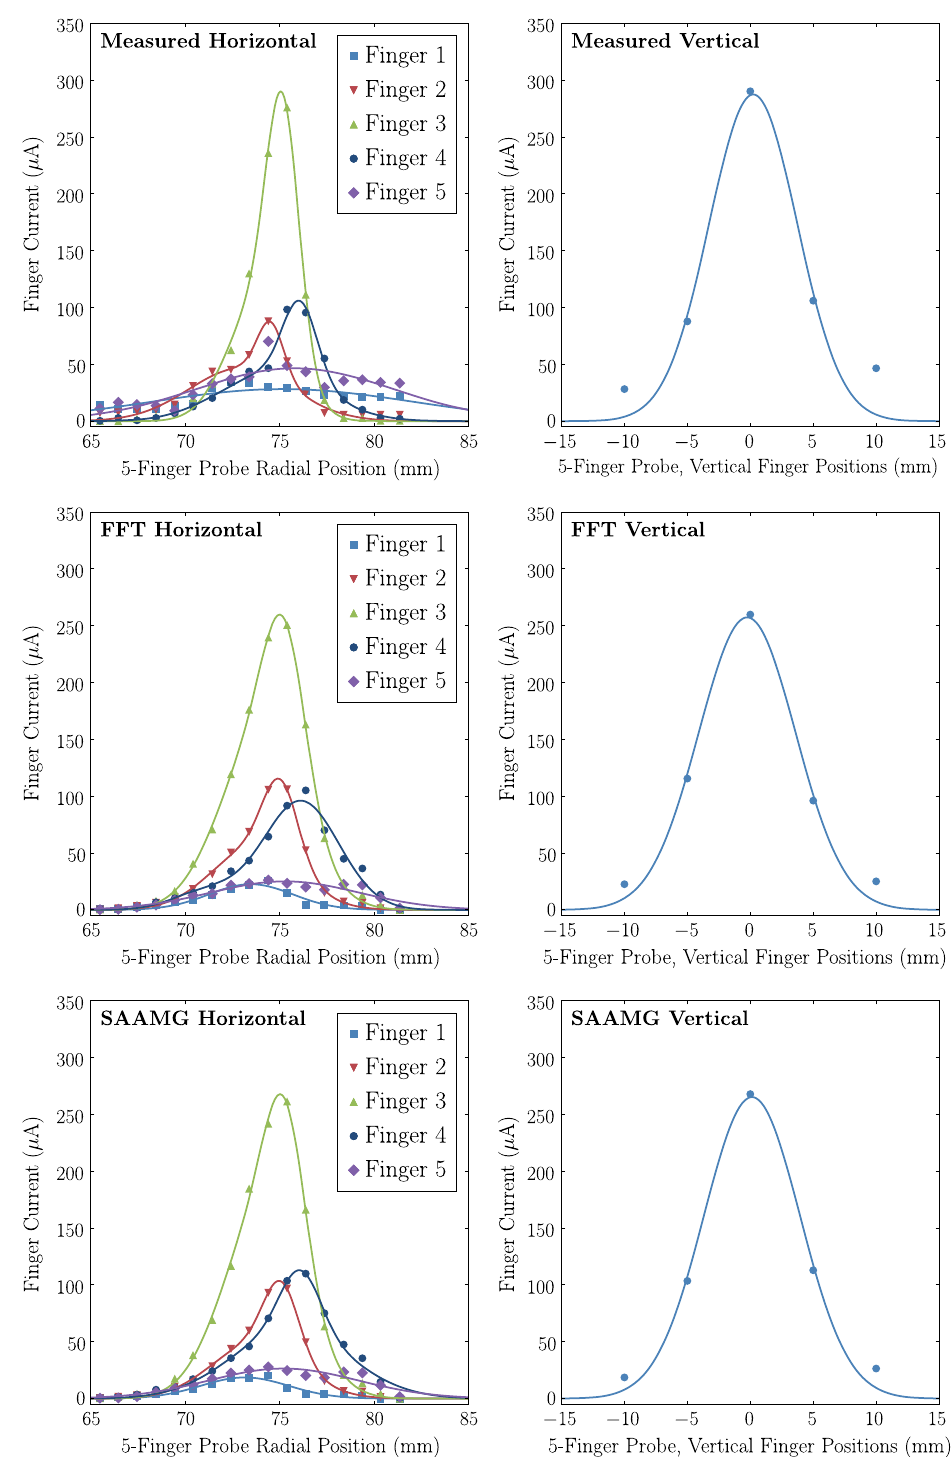
FIG. 10. Measurement and simulation of a 5-finger probe (for description cf. text) in the first turn of the BCS test cyclotron central region, 45° after the exit of the spiral inflector. Each finger has a main peak and a tail toward lower radius. These are the particles that are not sufficiently accelerated. To guide the eye and to compare with the simulations, the data for each finger is fitted with two